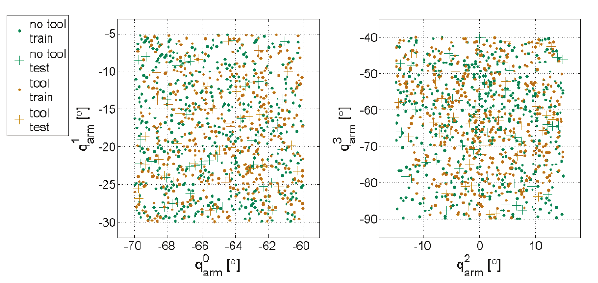
Figure 14. Distribution of arm joints values (i.e. model input) during motor bab- bling. Greencolor indicates without tool, browncolor with tool. Dots indicates training samples, crosses test samples.